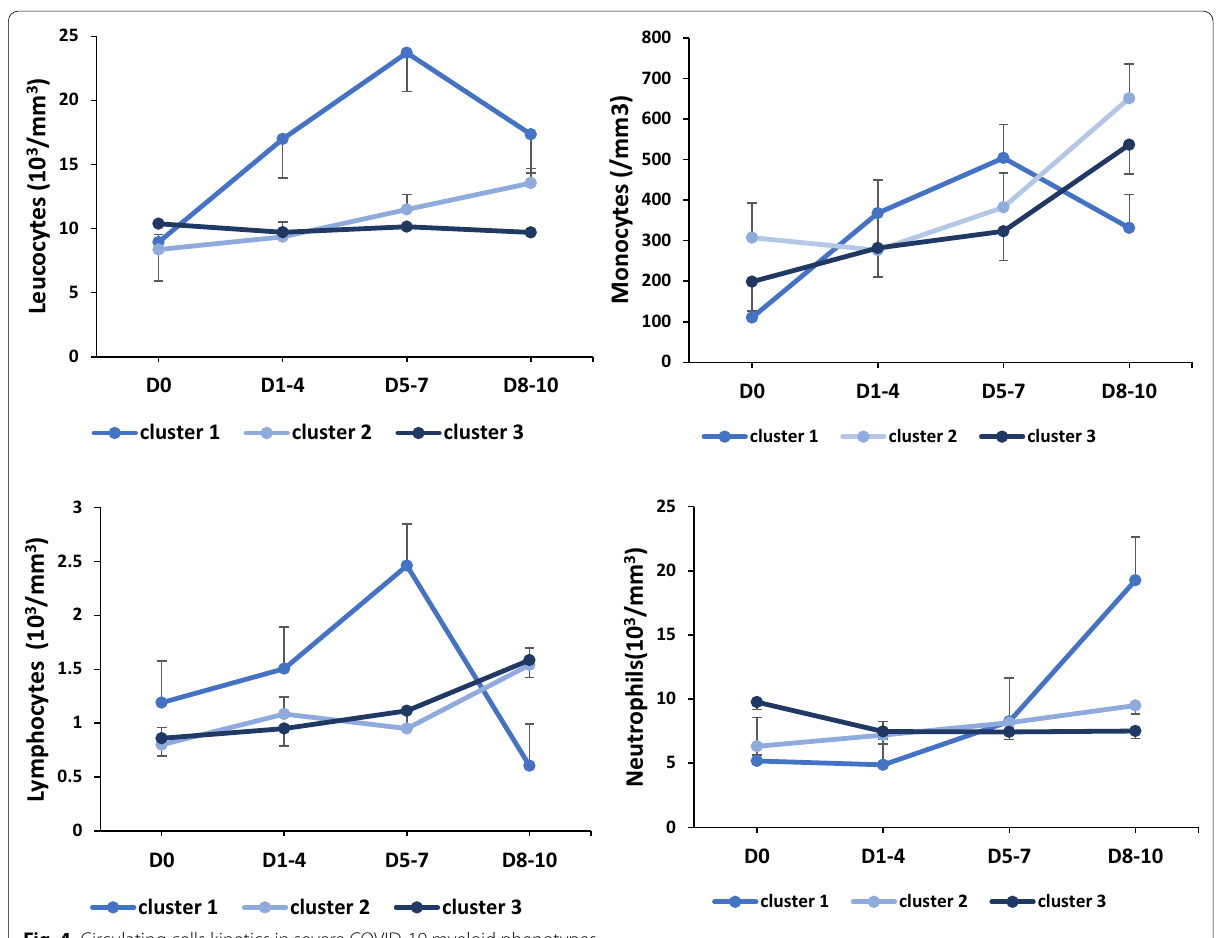
Fig. 4 Circulating cells kinetics in severe COVID‑19 myeloid phenotypes